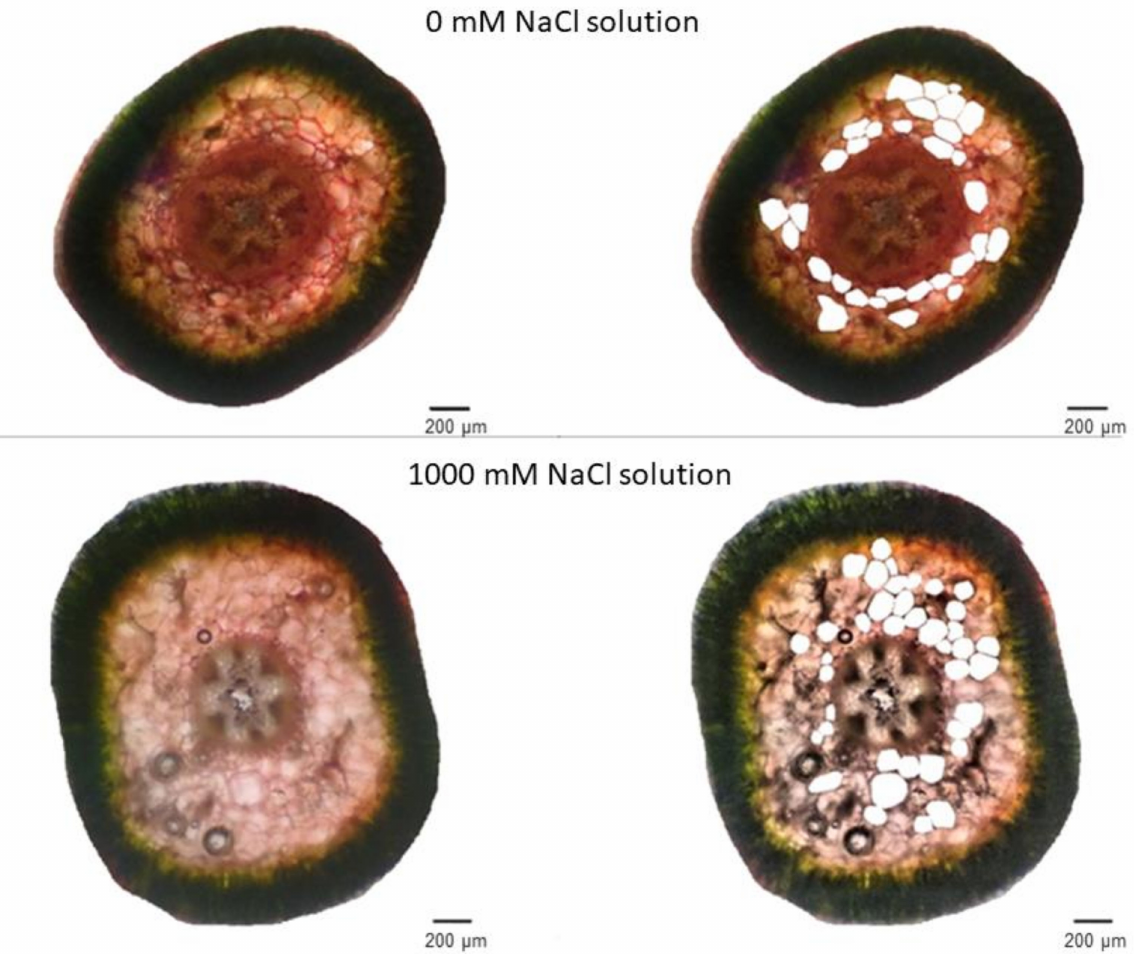
Figure 4. Stem cross-section of Salicornia europaea L. from plants treated with 0 and 1000 mM NaCl solutions. At the right side, example cortex cells for measurements by ImageJ software are marked as